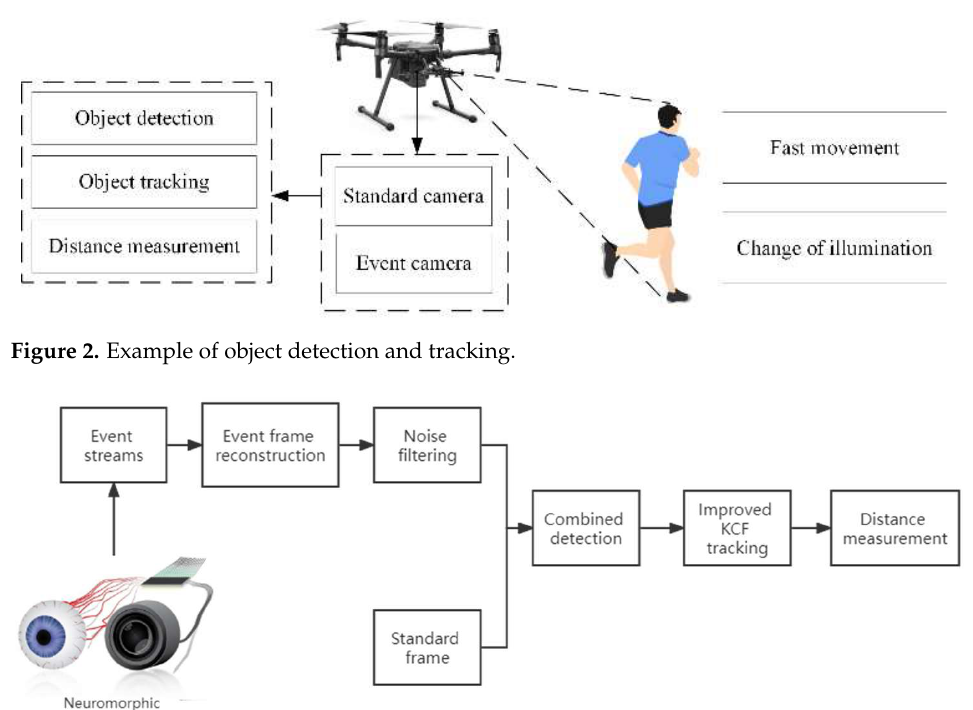
Figure 3. Framework of the event frame-based object detection and tracking scheme.